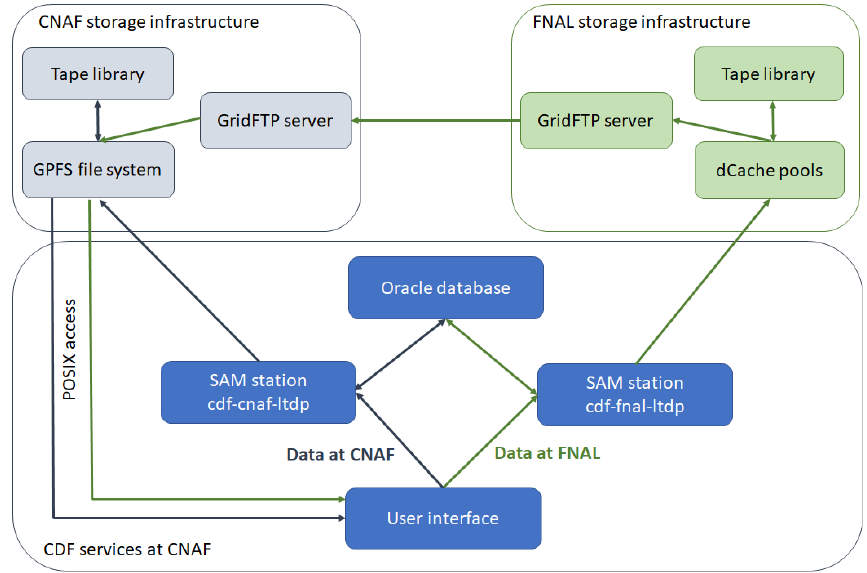
Figure 2. Flowchart showing CDF files delivery procedure from both CNAF and FNAL tape